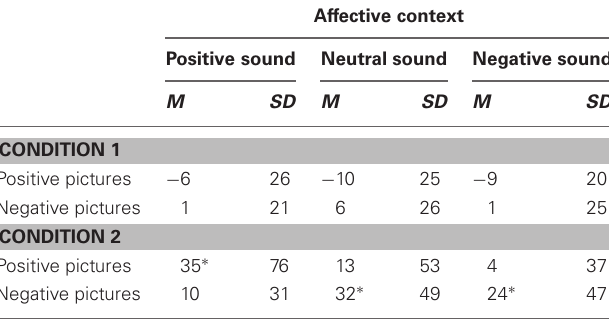
Frontiers in Human